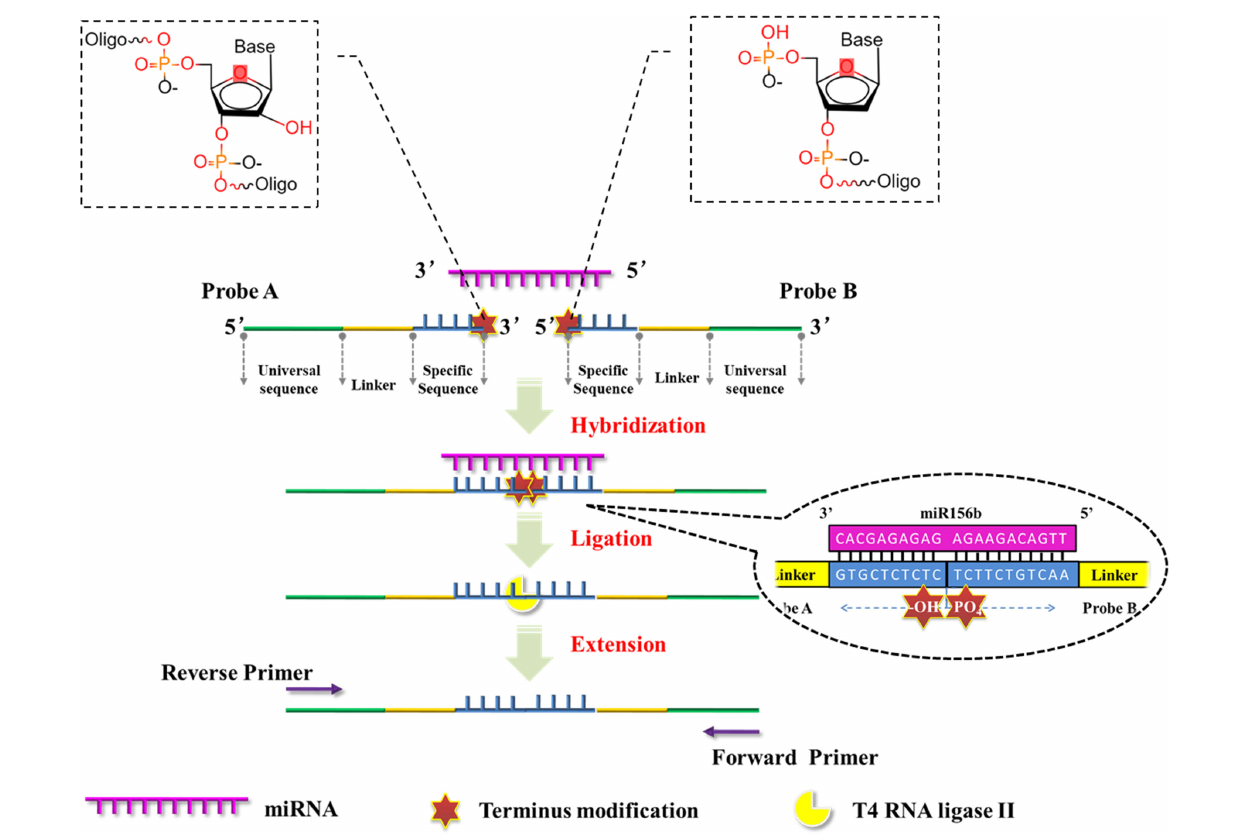
FIGURE 1 | Schematic representation of miRNA quantitative polymerase chain reaction (PCR) based on the ligation reactions of ribonucleotide-modified deoxyribonucleic acid (DNA)